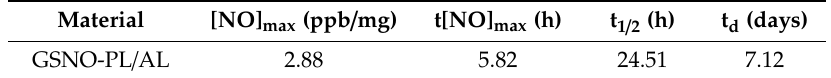
Figure 3. The nitric oxide (NO) release profile from the GSNO-PL / AL hydrogel. The black-colored line shows the real-time monitoring of NO release (ppb / mg) from GSNO-PL / AL hydrogel detected every five seconds; the red-colored line shows the percentage of NO release from the GSNO-PL / AL hydrogel. Table 2. NO release properties of GSNO-PL/AL hydrogel (37 °C).